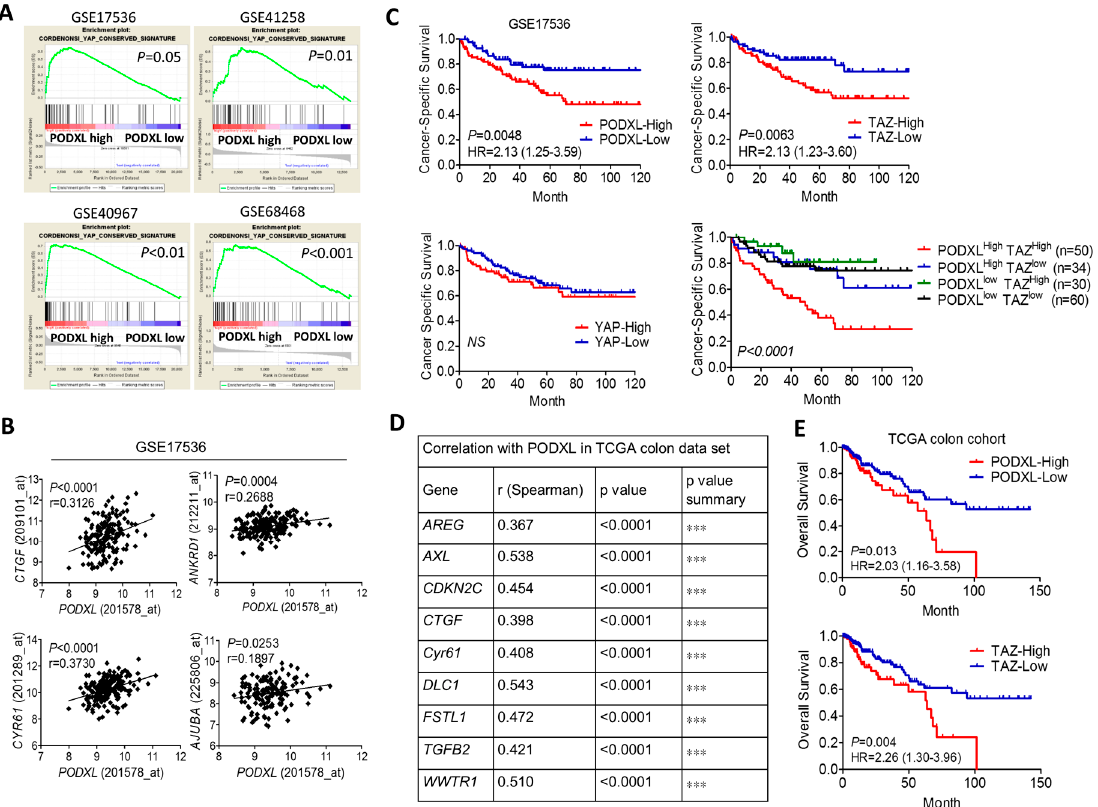
Figure 1. Expression of Podocalyxin-like Protein 1 (PODXL) is correlated with the Yes-associated Protein (YAP) signature and poor survival in colorectal cancer. ( A ) The gene set enrichment algorithm (GSEA) shows the association of PODXL with the -YAP signature in colorectal cancer (CRC). ( B ) Expression of PODXL was correlated with YAP/TAZ downstream genes in CRC. Data were retrieved from Gene Expression Omnibus (GEO) accession no. GSE17536. The correlation coefficient was determined by Spearman’s test. ( C ) Coexpression of PODXL and TAZ conferred poorer survival in CRC patients. Kaplan-Meier analysis of the cancer-specific survival of CRC patients according to PODXL and TAZ. The statistical difference was based on the log-rank test. ( D and E ) Expression of PODXL was correlated with TAZ downstream signaling ( D ) and poor overall survival outcomes ( E ) in the cancer genome atlas website (TCGA) colorectal cancer dataset (COADREAD). CTGF, connective tissue growth factor; CYR61, cysteine rich angiogenic inducer 61; ANKRD1, ankyrin repeat domain 1.